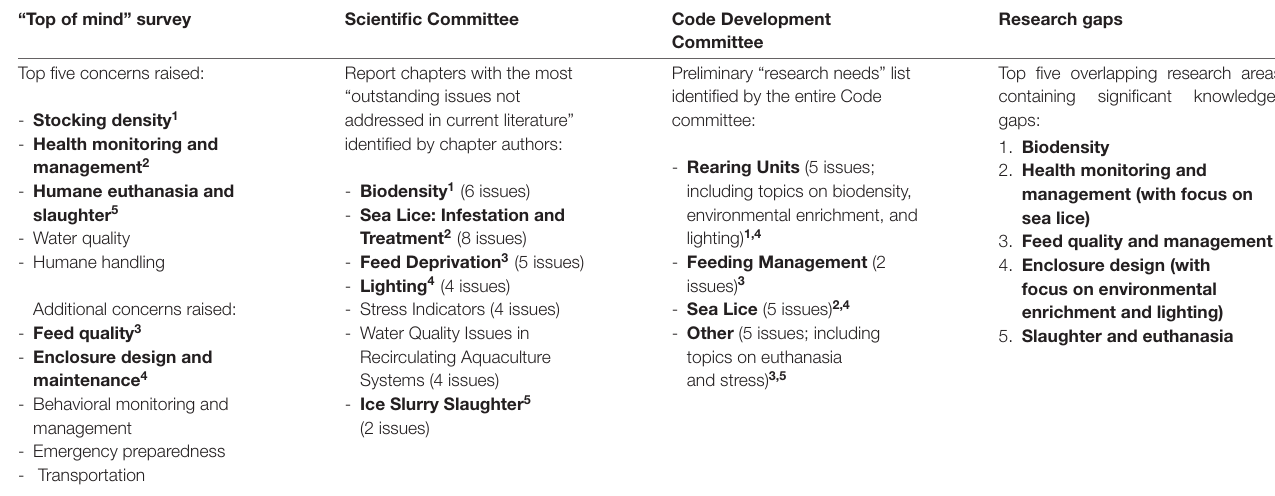
TABLE 1 | Illustration of Research Gaps arising from the “top-of-mind survey” conducted by NFACC, the list of “outstanding issues not addressed in current literature” created by the Scientific Committee and circulated internally, and the list of “research needs” published online by the Code Development Committee (22). “Top of mind”